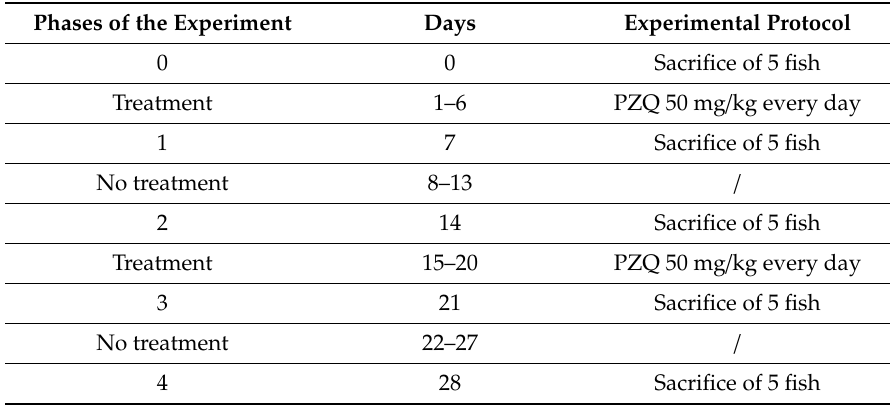
Table 2. Fish treatment with PZQ (50 mg /